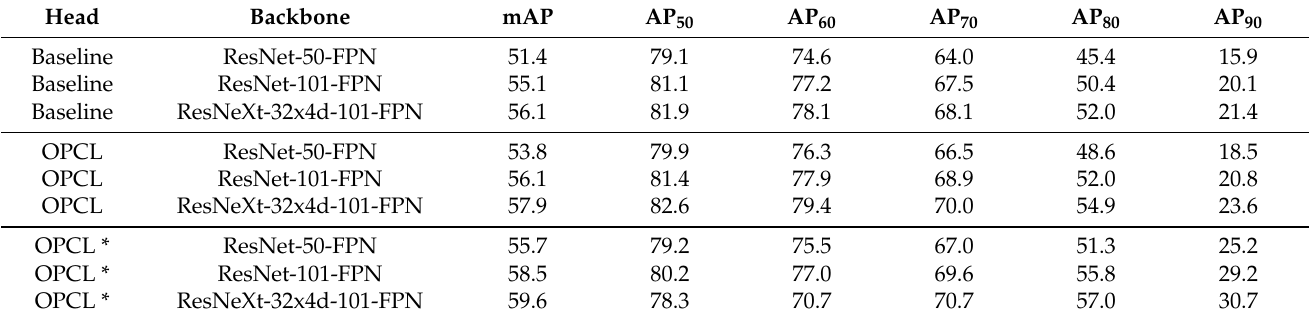
Table 5. Experimental results on PASCAL VOC. All the models were trained on VOC2007 trainval and VOC2012 trainval and evaluated on VOC2007 test with the image scale of [600, 1000]. All the other settings were adopted as the same as the default settings provided in the MMDetection. The symbol “*” means the gradient of OPCL with respect to IoU was computed during training.